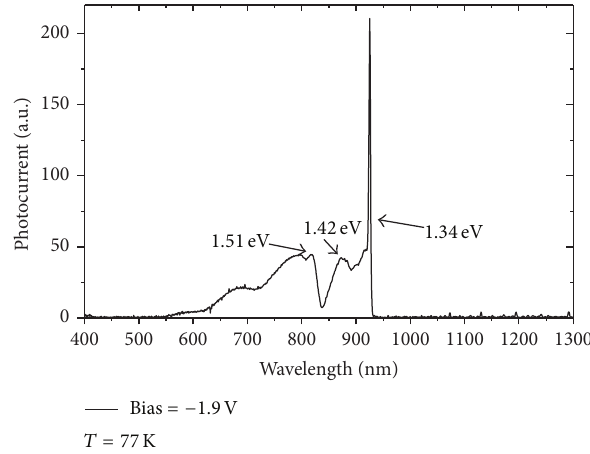
Figure 4: Representative photocurrent spectrum of the detector at 𝑇 = 77 K.